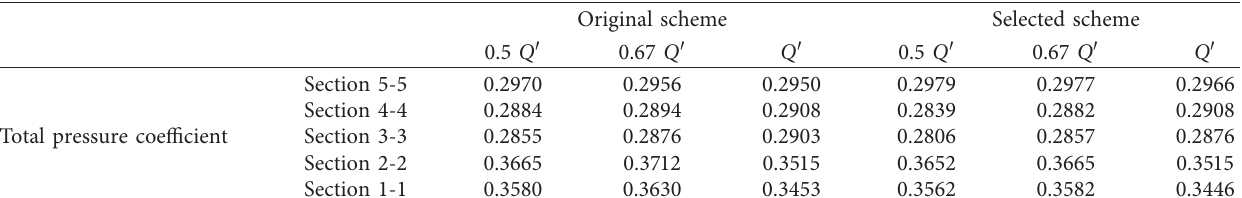
Figure 8: Schematic diagram of sections distribution in the device. Table 5: Total pressure coefficient on each section.